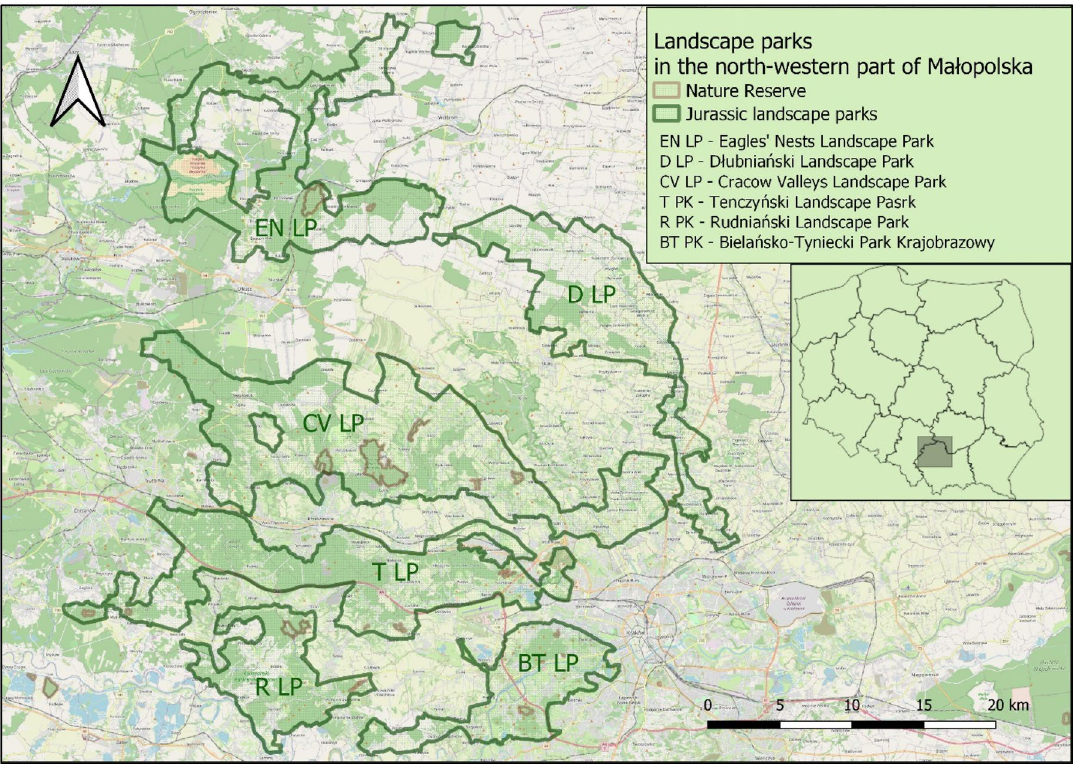
Figure 1. Location of landscape parks (LP) in South Poland